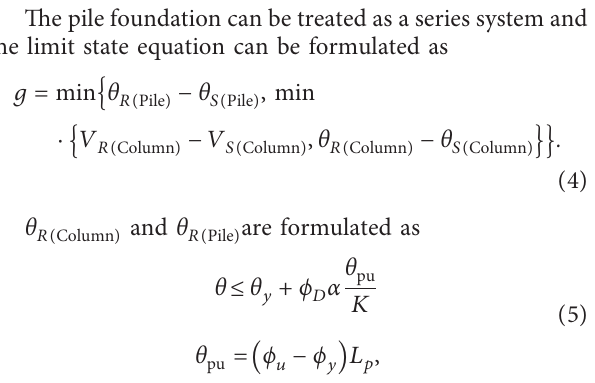
Figure 2: Flowchart of failure probability